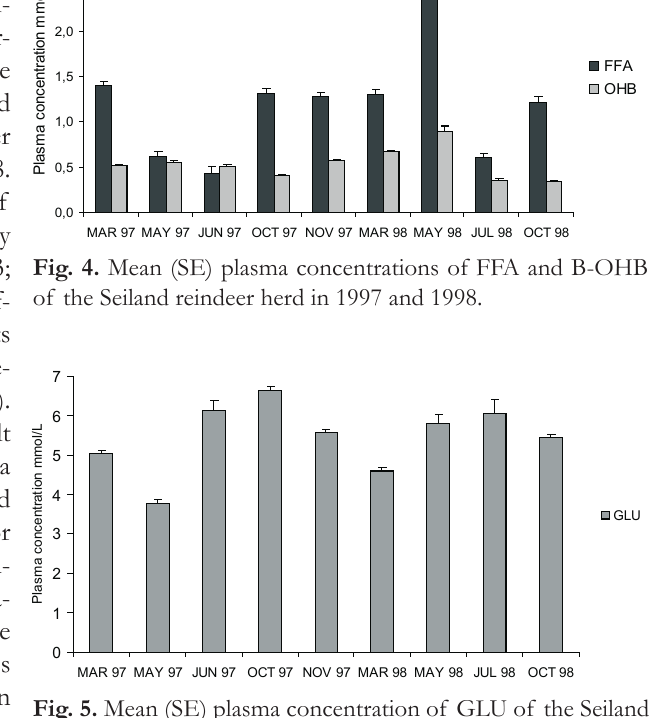
Fig. 5. Mean (SE) plasma concentration of GLU of the Seiland reindeer herd in 1997 and